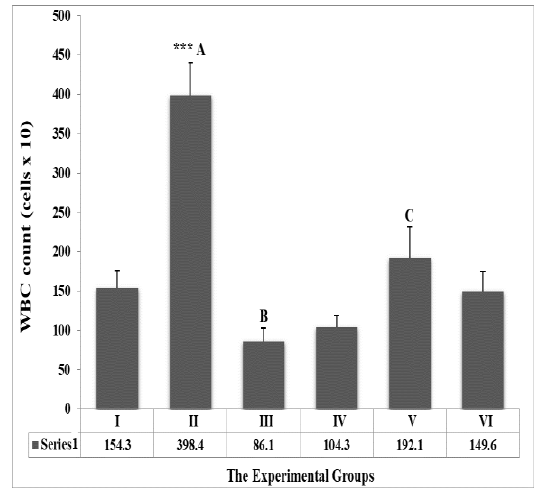
Figure 1. The effect of guggulsterone on WBC counts in bronchoalveolar lavage fluid of OVA- Induced Asthma in Rats. Values are indicated as means ± Std. Error (n=8) for each group. Group I: Control group, Group II: Positive control group (with sensitization), Group III: Guggulsterone (25 mg/kg) with sensitization, Group IV: Guggulsterone (50 mg/kg) with sensitization, Group V: Predinsoline (4.12 mg/kg) with sensitization, Group VI: guggulsterone (50 mg/kg) without sensitization. *** symbol referred to significant different (p<0.001) compared to control group, unpaired test student t-test. Groups with non- identical letters are significantly different